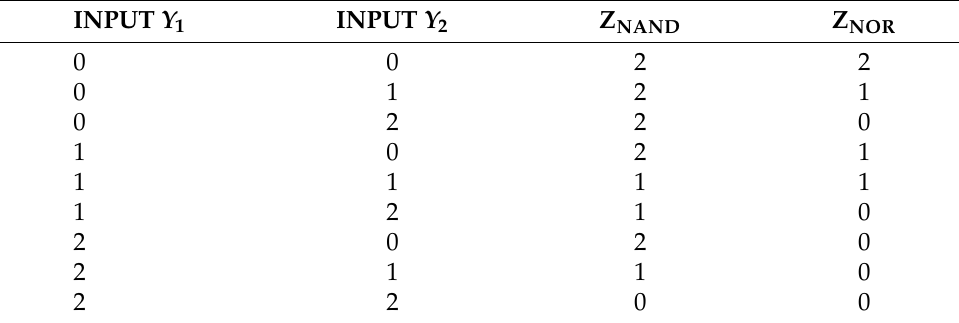
Table 3. Truth table of ternary NAND and ternary